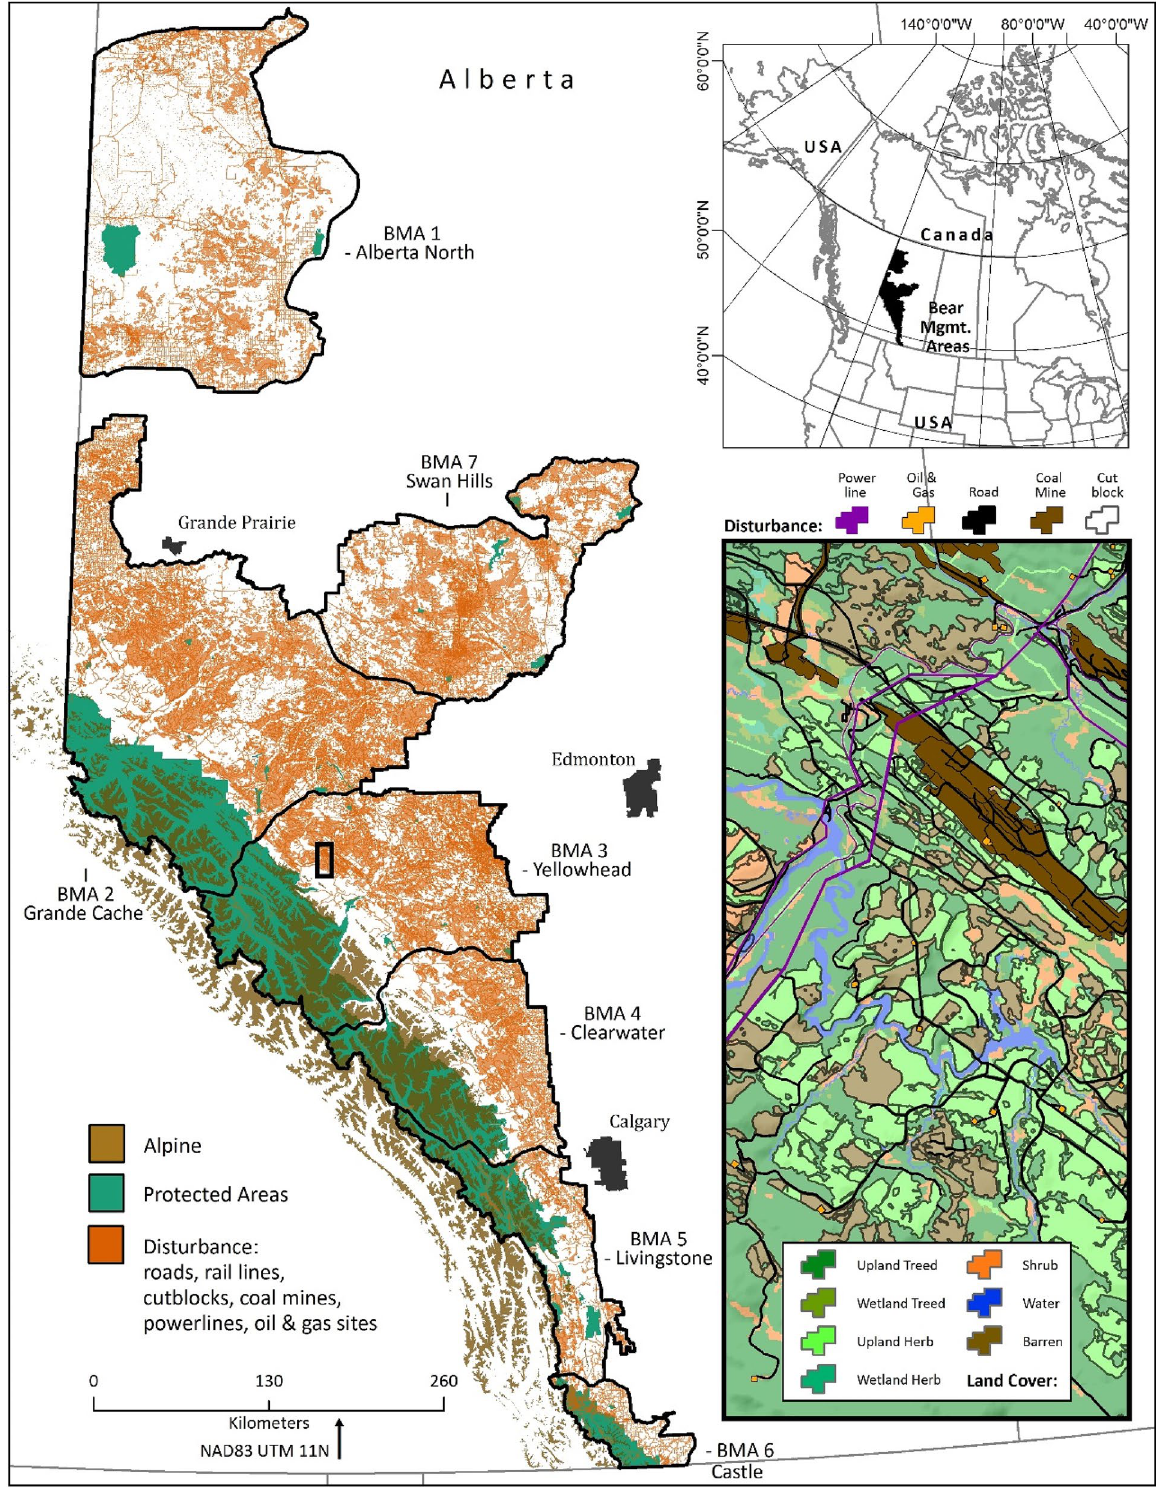
Figure 6. Study area location in Alberta, Canada. Skin samples were collected from free-ranging grizzly bears from 2013–2019 in Clearwater, Yellowhead, and Grande Cache bear management areas (BMA). On main layout, disturbance from ABMI HF118 (http:// www. abmi. ca) was grouped and mapped. Alpine and protected parks boundaries were added. On subset map, land cover 91 was mapped, and ABM HFI disturbance features were added. ArcGIS Desktop 10.3.1 software was used (https:// deskt op. arcgis. com/